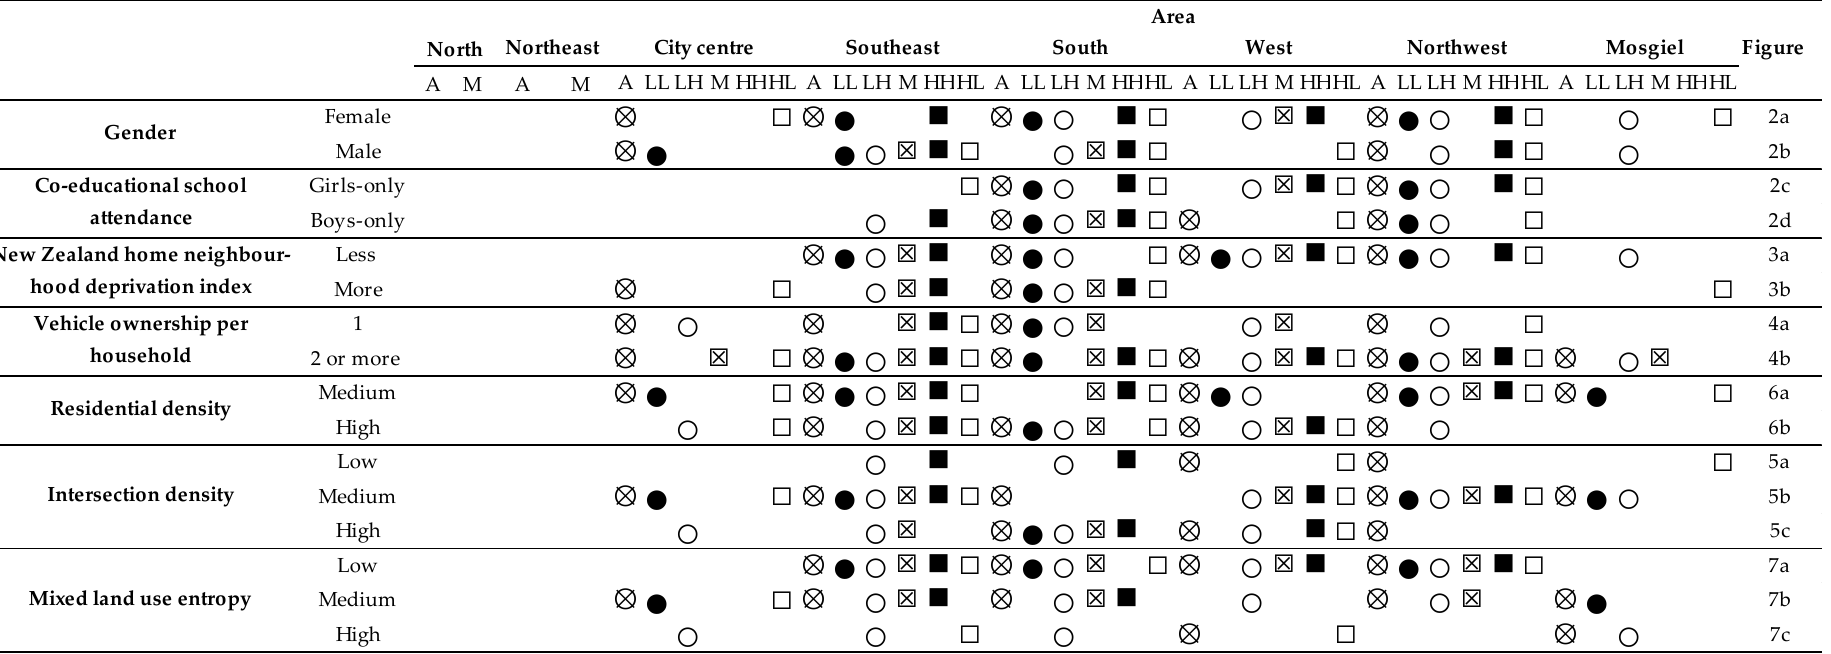
Figure 8. Summary of the KDE and LISA pattern distribution of individual ATS factor groups over eight zones within the study site .